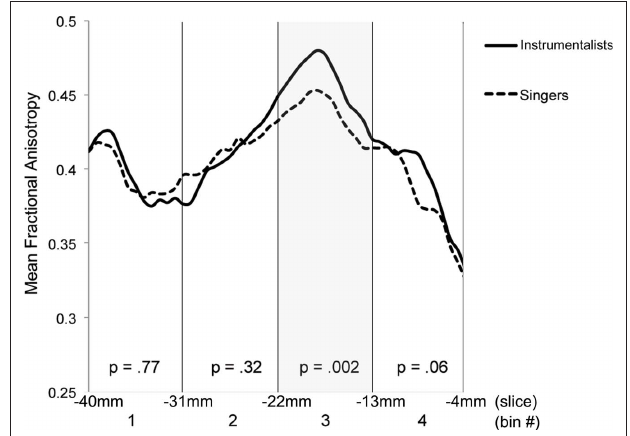
Figure 5 | Mean FA by bin number for left dorsal AF of singers and instrumental musician